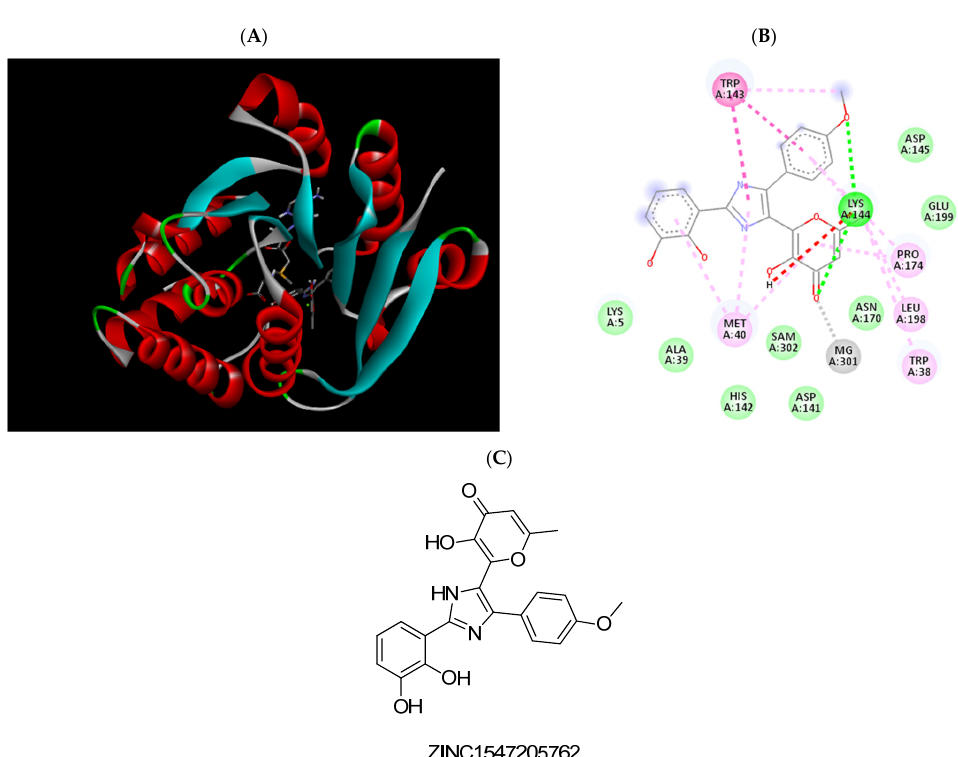
Figure 4. ( A ) Binding modes of ZINC1547205762 with the crystal structure of human COMT complexed with SAM and Mg 2+ , ( B ) receptor–ligand interactions, ( C ) 2D representation of ZINC1547205762.